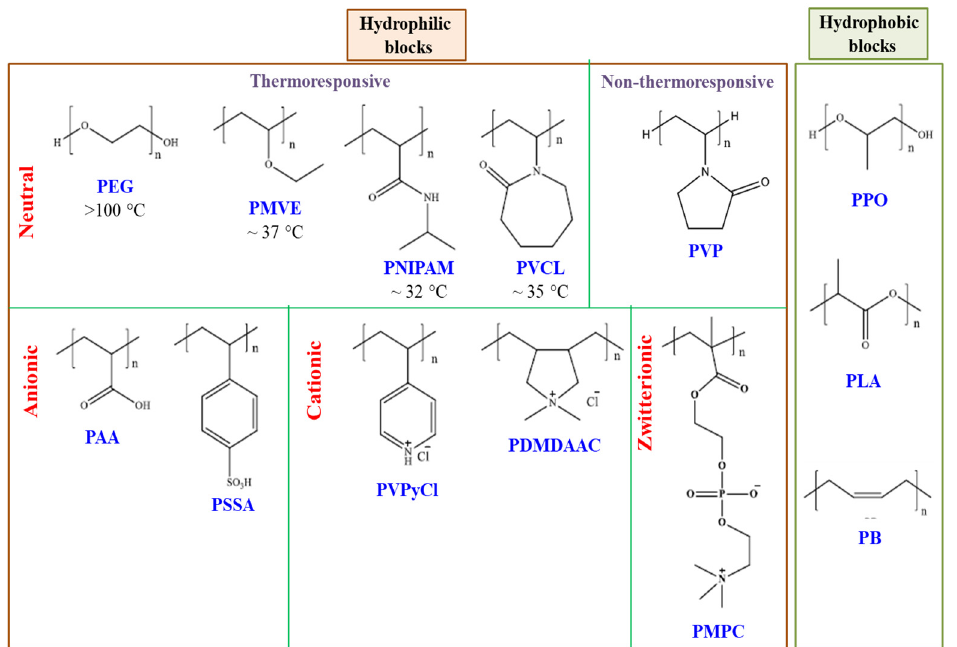
Figure 2. Examples of polymers with varied nature of hydrophilic and hydrophobic blocks.